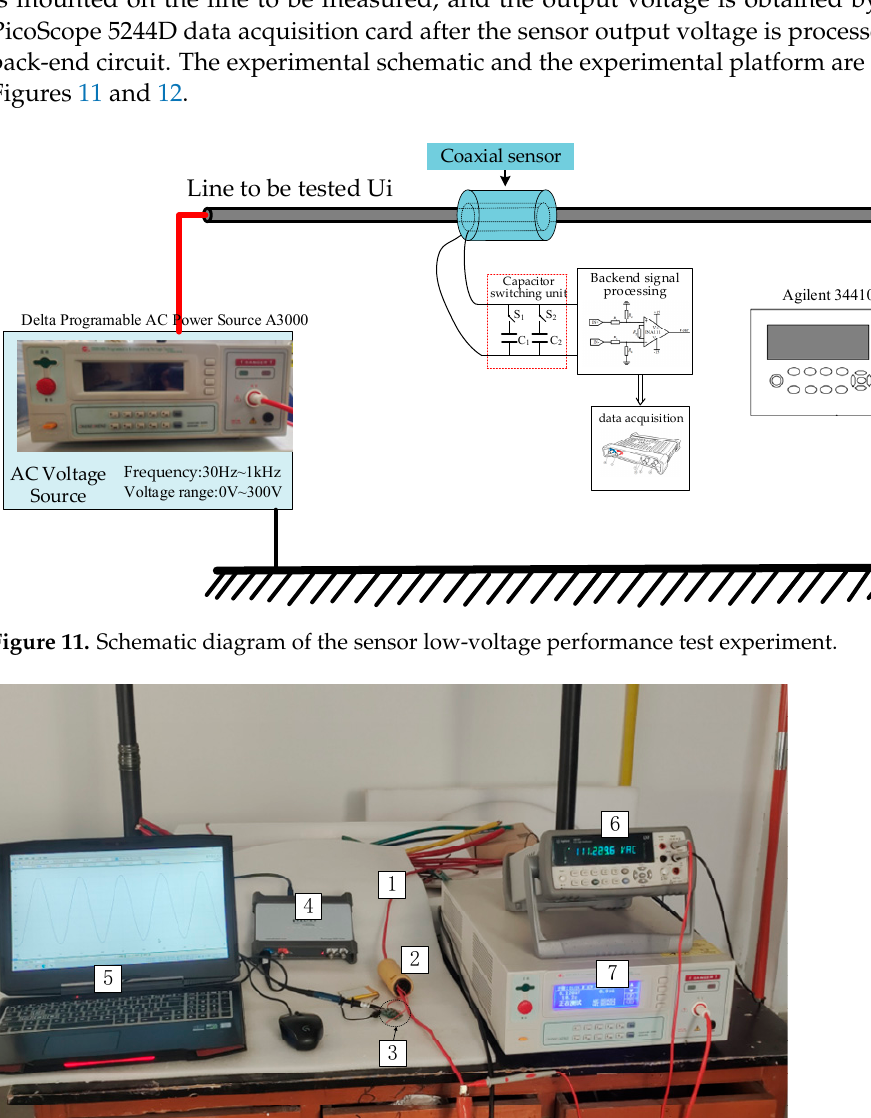
Figure 12. Sensor low voltage performance test platform.